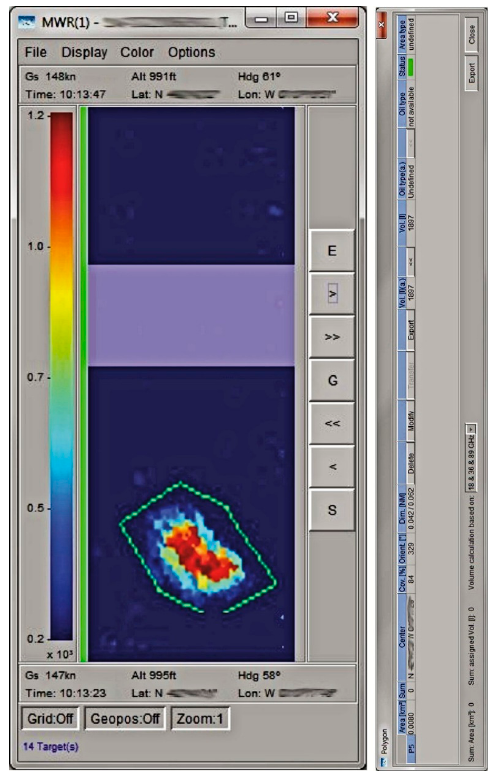
Figure 11. A slick thickness profile from a passive microwave sensor (photo from Nils Robbe, Optimare). The colors represent thicknesses as shown on left hand scale (thickness ranges from 0.2 to 1.2 mm in this case). This image was taken directly from an operating aircraft display. The information available on the display includes location, area of slick (here 0.008 km 2 ), and oil volume (here 1897 L). The microwave instrument was a 3-band passive microwave with receivers at 18, 36, and 89 GHz.